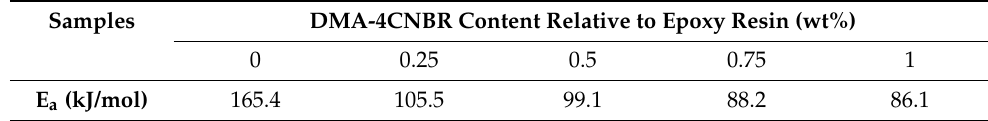
Figure 3. DSC thermograms of ( a ) neat epoxy, ( b ) 0.25phr DMA-4CNBR/EP, ( c ) 0.5phr DMA-4CNBR/EP, ( d ) 0.75phr DMA-4CNBR/EP, and ( e ) 1phr DMA-4CNBR/EP, at different heating rates. ( f ) The correlation fitting curves of different content DMA-4CNBR modified epoxy resin systems based on Kissinger’s theories. Table 2. Curing kinetics data of different content DMA-4CNBR/EP